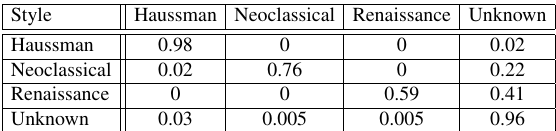
Table 2: Confusion matrix for the style classification